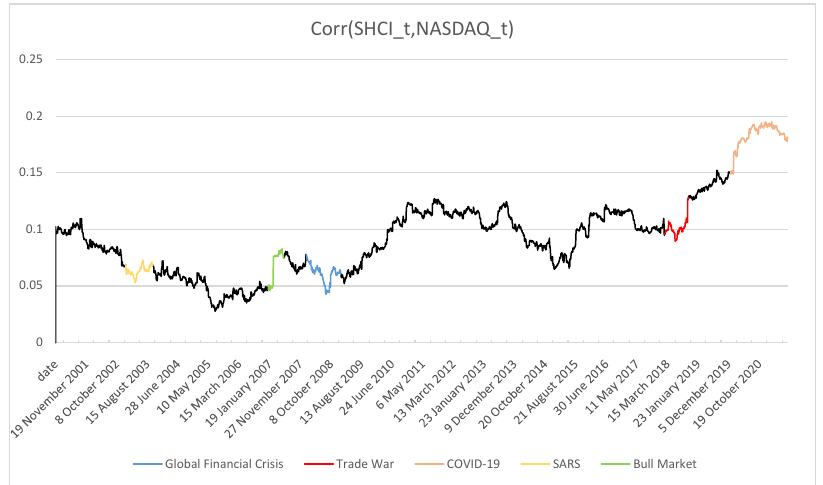
Figure 4. Dynamic correlation between SHCI and NASDAQ.